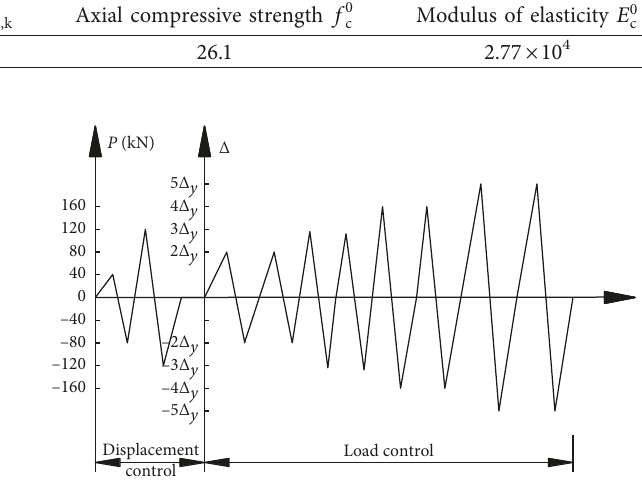
Figure 4: Low-cycle reversed loading